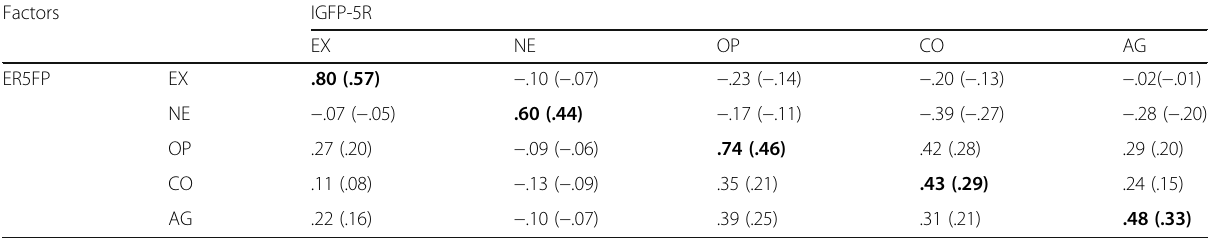
Table 6 Raw and corrected for attenuation correlation coefficients between factors of the ER5FP and IGFP-5R scales ( N = 554)